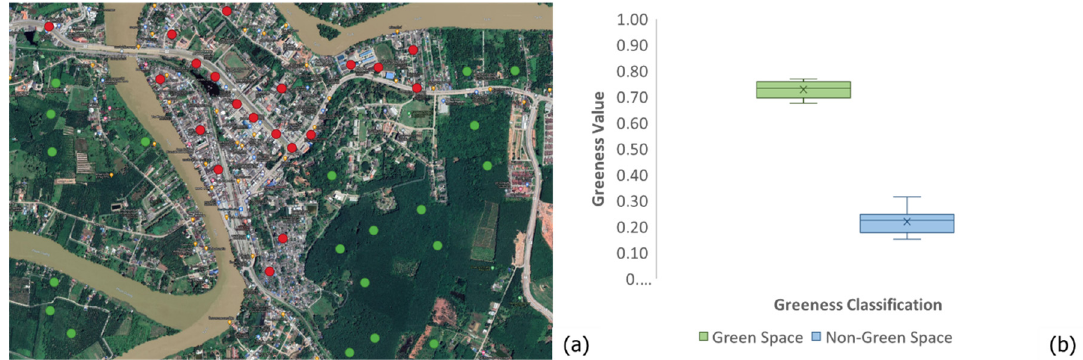
Figure 15. Green space (green circles) and non-green space (red circles) areas in Phunphin district ( a ) and Box-Whisker plot showing the distribution of their greenness values ( b ).